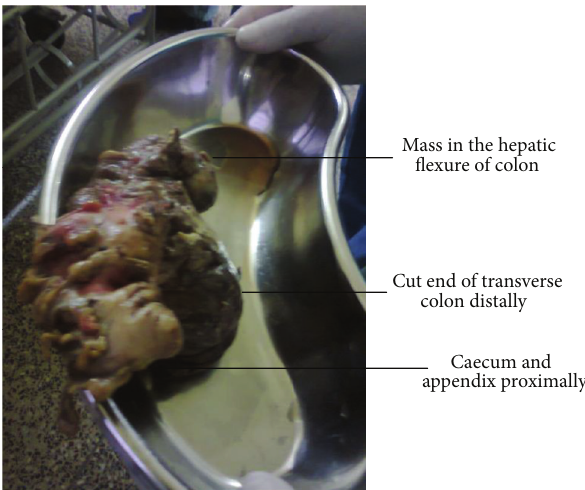
Figure 1: Intraoperative appearance of Inflammatory Fibroid Polyp arising from the hepatic flexure of colon. Caecum and appendix can be seen proximally and cut section of transverse colon can be seen distally.